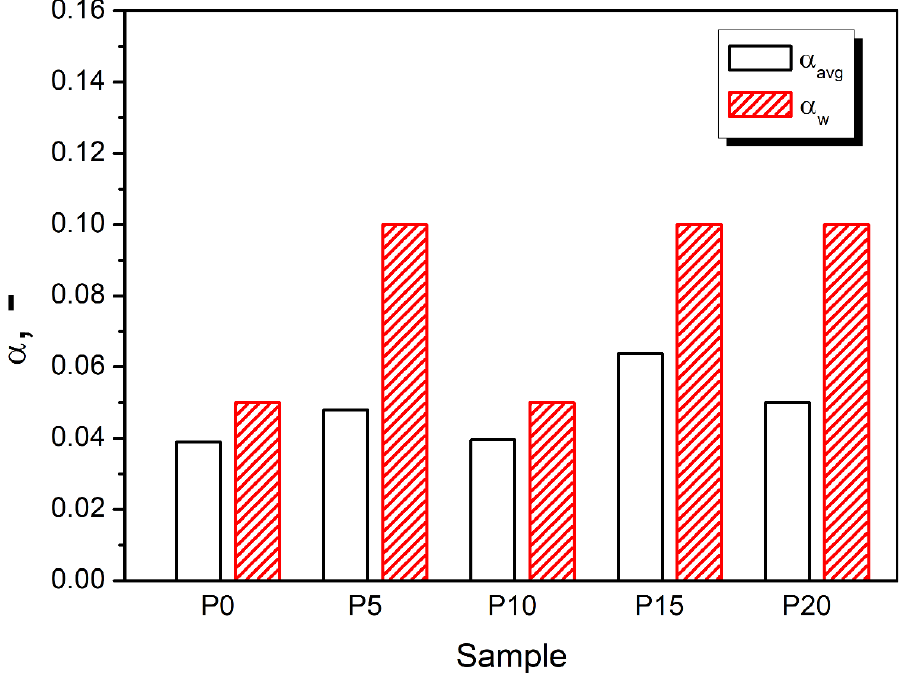
Figure 6. The average value of the sound absorption coefficient α avg and the weighted sound ab- sorption coefficients α w of PU foams depending on GTR content. coefficients α w of PU foams depending on GTR